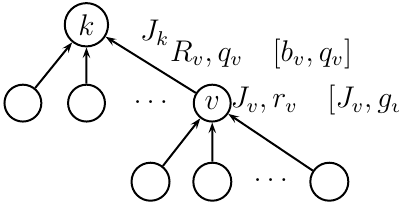
Figure 8. Notation for the local optimization problem. In-network processing parameters are shown between